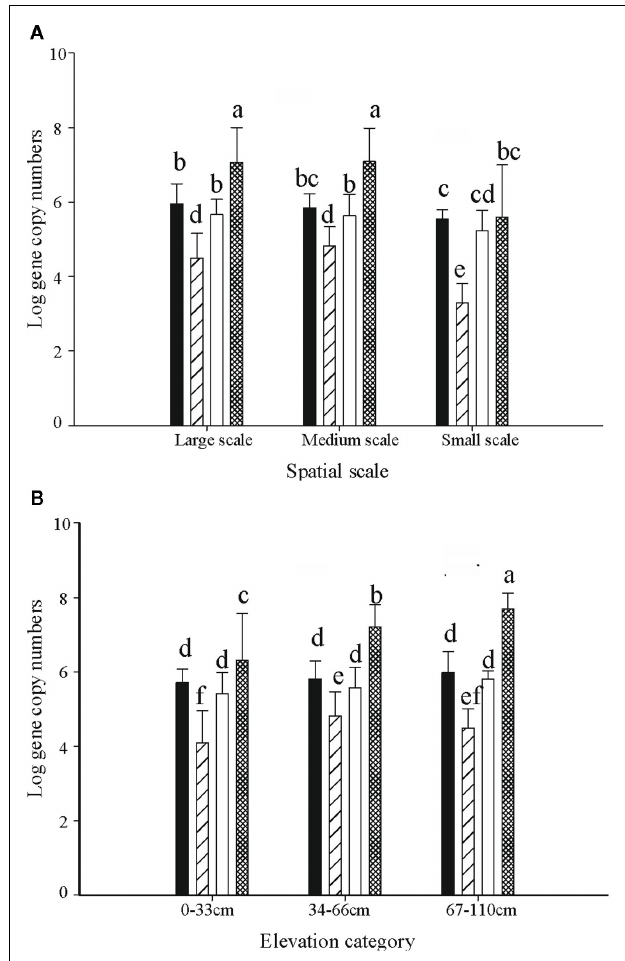
FIGURE 5 |The distribution of 16s rRNA copy numbers of Ga-FeOB and pmoA gene copy numbers of MOB (both expressed per gram of dry soil) at different spatial scales (A) and elevation levels (B). Indicated are means ± SD. Black bars depict type II, striped bars type Ia, and white bars type Ib MOB, while hatched bars show the Ga-FeOB. Different letters indicate significant differences ( p < 0.01) between bars. For numbers of observations see footnote of Table 1